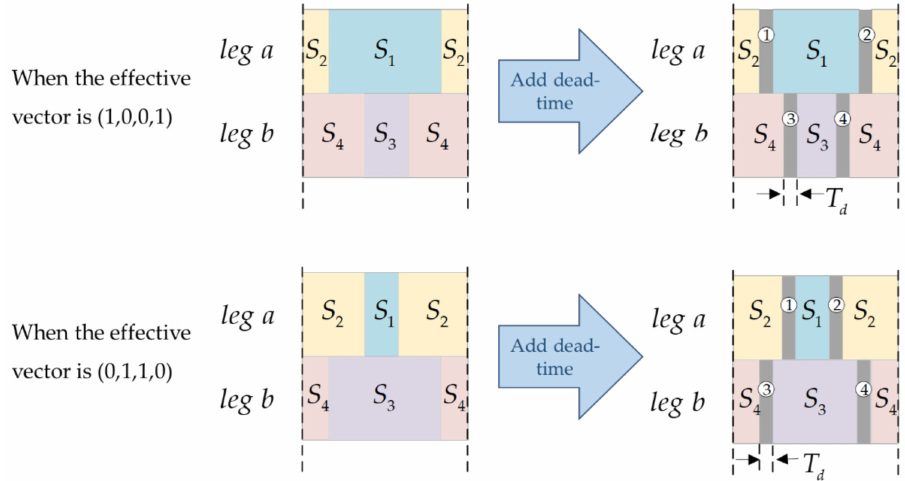
Figure 6. Comparison of switch states before and after adding